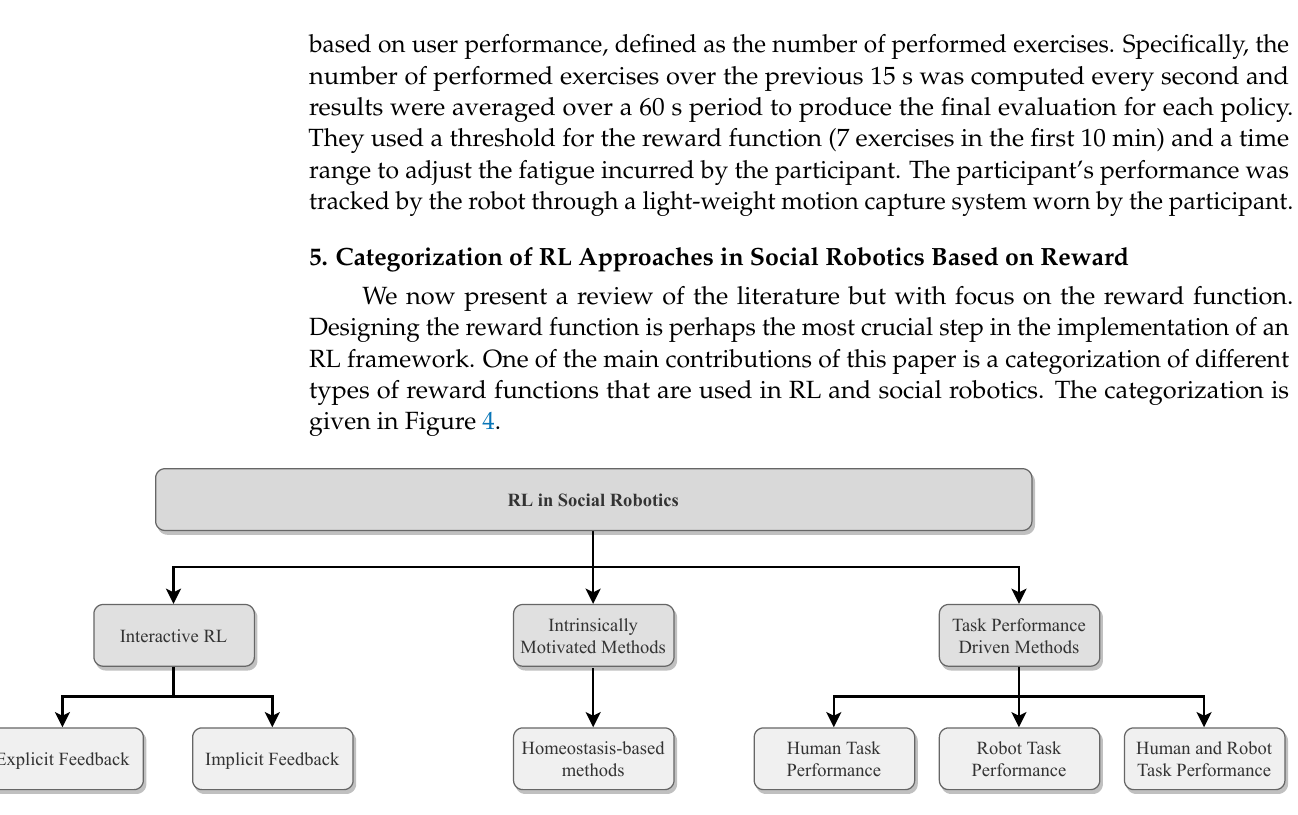
Figure 4. Reinforcement Learning approaches in social